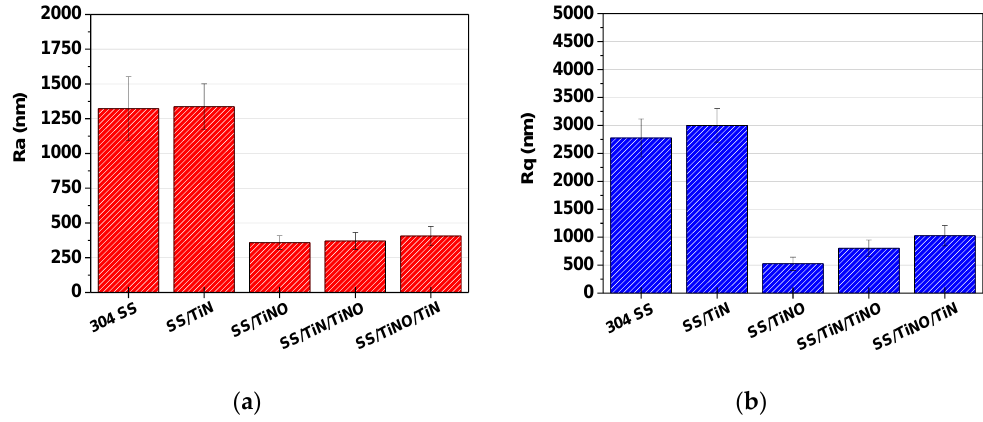
Figure 6. Roughness parameters after corrosion tests: ( a ) R a –arithmetic average deviation from the mean line; ( b ) R q –root mean square average of the profile heights over the evaluation length.